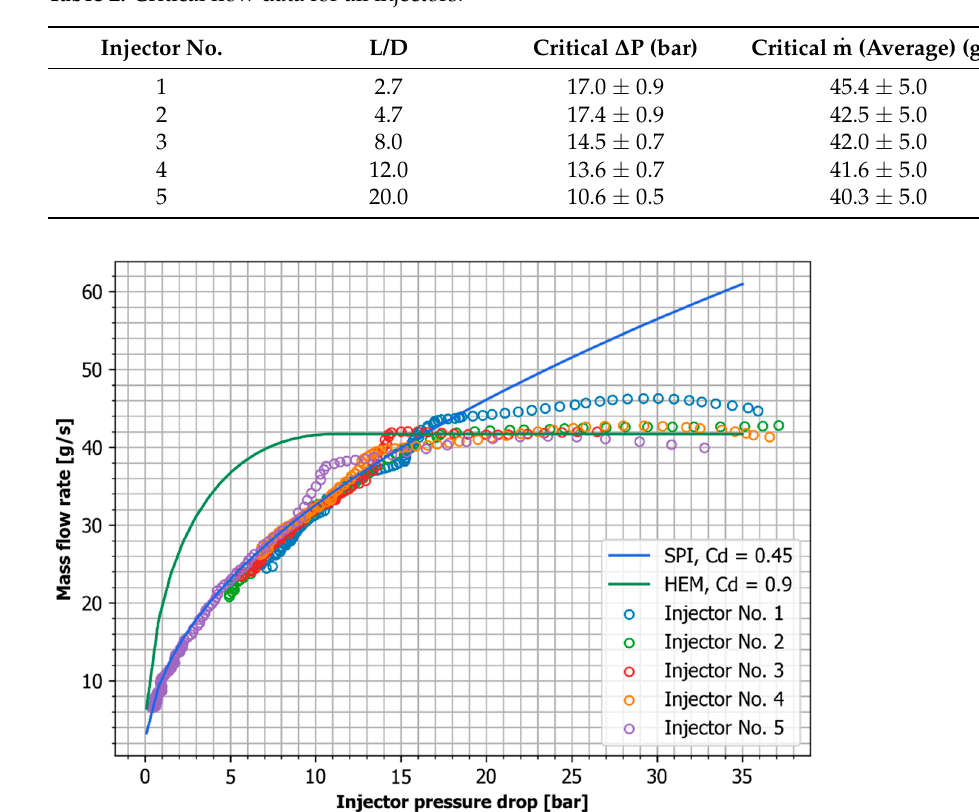
Figure 9. Mass flow rate versus injector pressure drop ∆ P for all injector designs. SPI and HEM curves are roughly fitted, showing similar flow performance for the injectors.